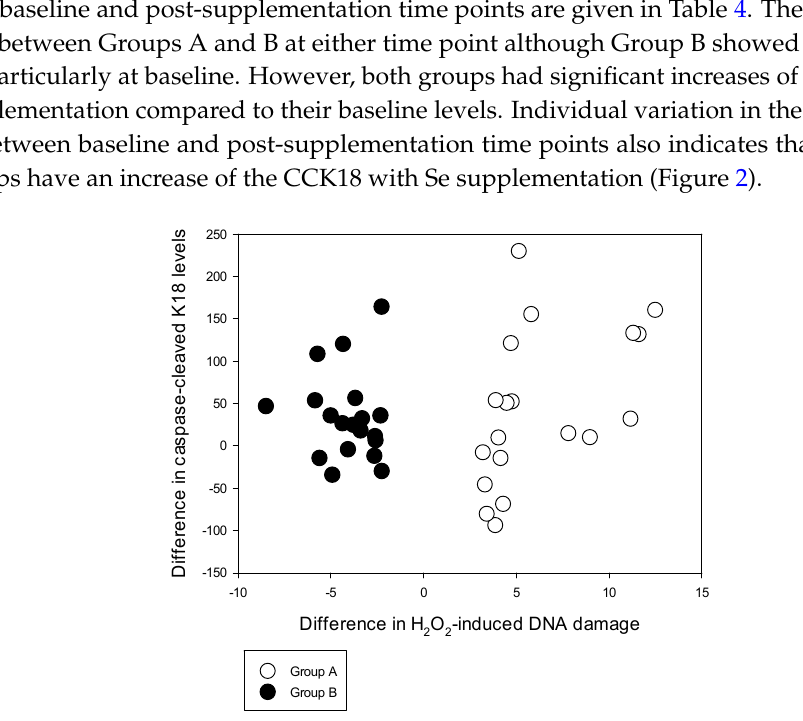
Figure 2. Distribution of individual differences of the caspase ‐ cleaved K18 levels against differences in the H 2 O 2 ‐ induced DNA damage levels among subgroups A and B between baseline and post ‐ supplemented time points.